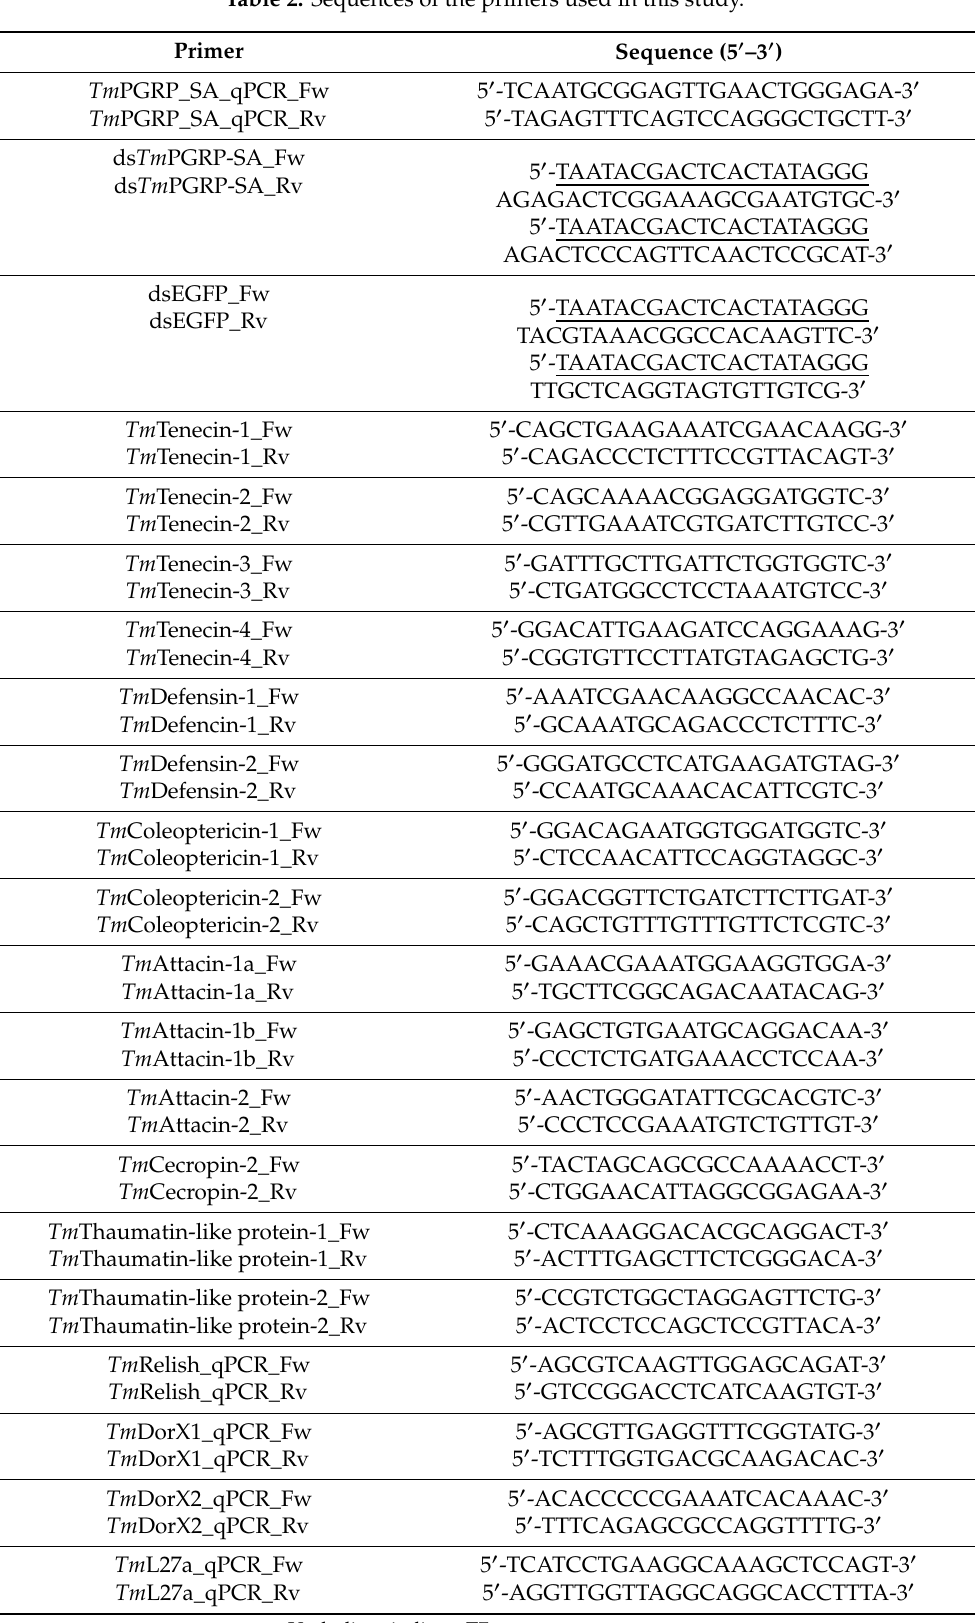
Table 2. Sequences of the primers used in this